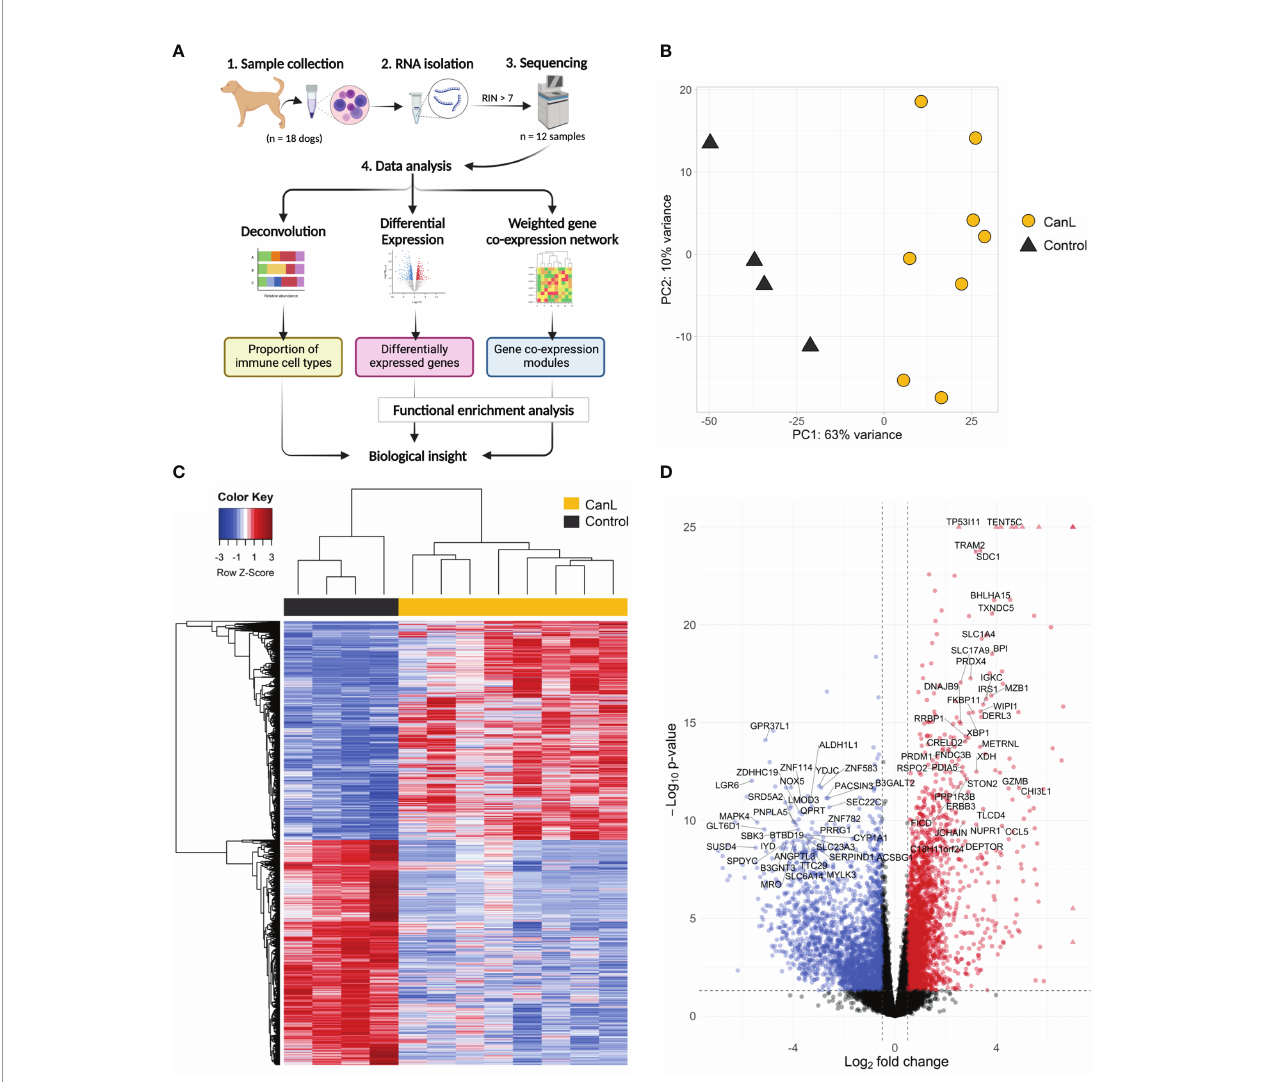
FIGURE 1 | (A) Overview of the study work fl ow (created with BioRender.com). (B) Principal component analysis of the samples showing PC1 and PC2. (C) Heatmap of the most variable genes expressed in dogs with CanL vs. healthy dogs. Expression pro fi les for the 1,500 genes with the highest variability that shown signi fi cant expression changes in dogs with CanL (right) and healthy dogs (left). Red represents genes overrepresented in CanL samples, and blue indicates genes overrepresented in controls. (D) Volcano plot where mean log 2 FC is plotted against the – log 10 FDR adjusted P-values for all expressed genes. Each point represents a gene, and those with FDR < 1x10 -26 and/or log 2 FC > 7 are displayed as triangles. Genes that reach the cut-off values (FDR < 0.05 and absolute log 2 FC > 0.5) are highlighted. Labels are displayed for the most signi fi cant (FDR < 10 -8 and absolute log 2 FC > 2.5) protein-coding